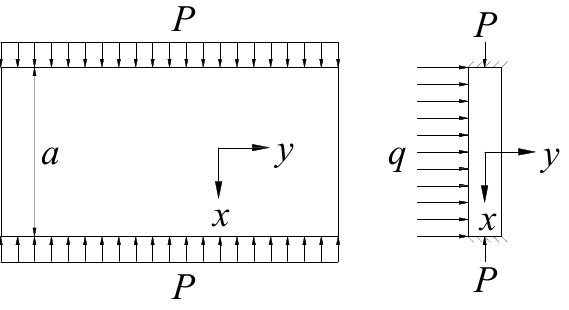
Figure 7. Mechanical model of composite roof strata. Under the stress of distributed load q , the elastic surface differential equation of layer n 1